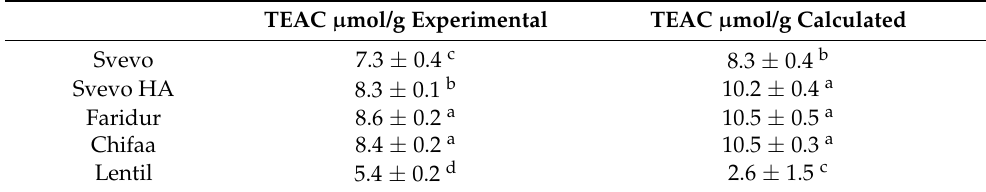
Table 6. Composition of experimental and calculated TEAC values of polyphenol extracts for Svevo, Svevo-HA, Faridur, Chifaa and lentil. a–d Different letters within each column show significant differences ( p <